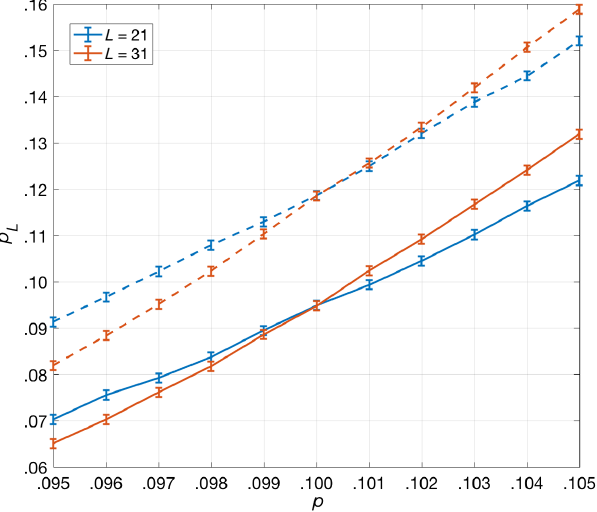
FIG. 3. A comparison of logical error rates for the asymmetric decoder (solid lines) versus the symmetric decoder (dashed lines). Each data point was generated with 10 6 independent Monte Carlo